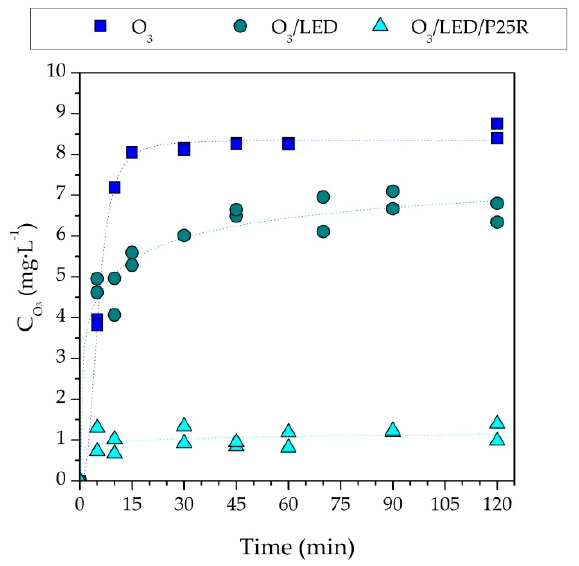
Figure4. EvolutionofdissolvedozoneconcentrationinCEC-freedeionizedwaterincontinuousoperation. Figure 4. Evolution of dissolved ozone concentration in CEC-free deionized water in continuous operation. Table 4. Apparent pseudo first order rate constant and Hatta number (Ha) values for ozone decomposition in water in the presence of radiation and radiation /